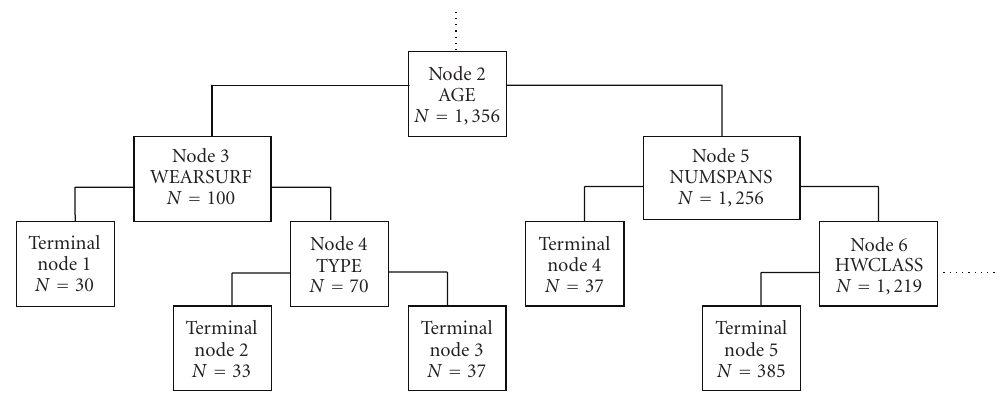
Figure 4: Illustration of hierarchical tree-based regression analysis results for AGE.